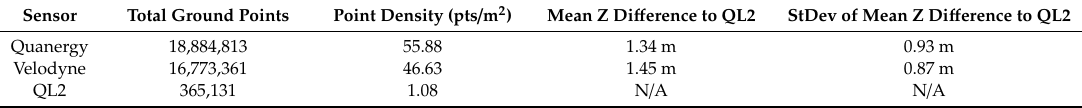
Table 3. Basic statistics for cloud-to-cloud comparison performed in CloudCompare using Quanergy M8, Velodyne HDL-32E, and North Carolina Quality Level 2 (QL2) LiDAR datasets. Metrics include the total number of ground points within the area of interest (AOI), point density (calculated by dividing the total points by the area of the AOI), mean Z di ff erence to QL2, and standard deviation (StDev) of mean Z di ff erence to